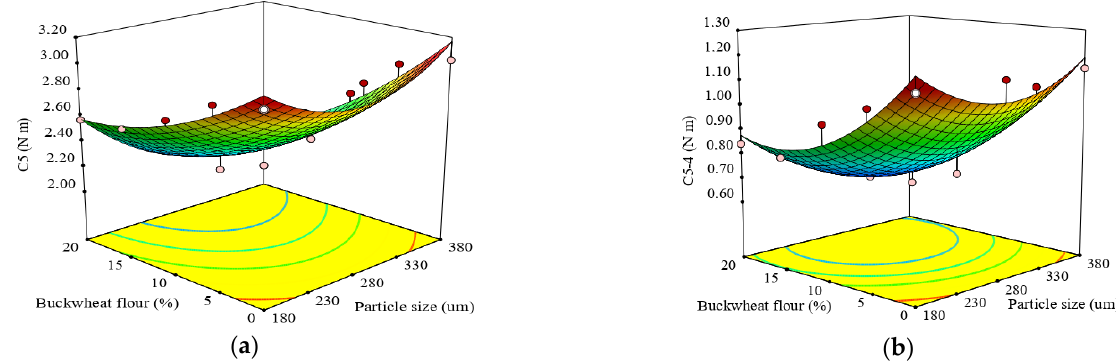
Figure 5. 3D response surface plots showing interaction between buckwheat flour particle size and addition level on ( a ) C5 torque (C5) and ( b ) difference between torques C5 and C4 (C5–4) during starch retrogradation.